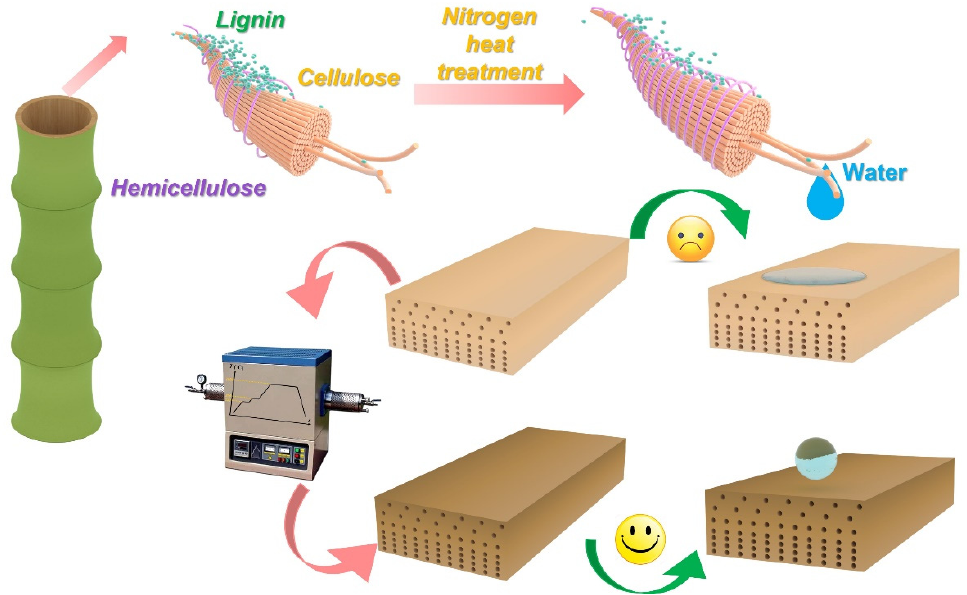
Figure 12. Schematic diagram of thermal modification mechanism .